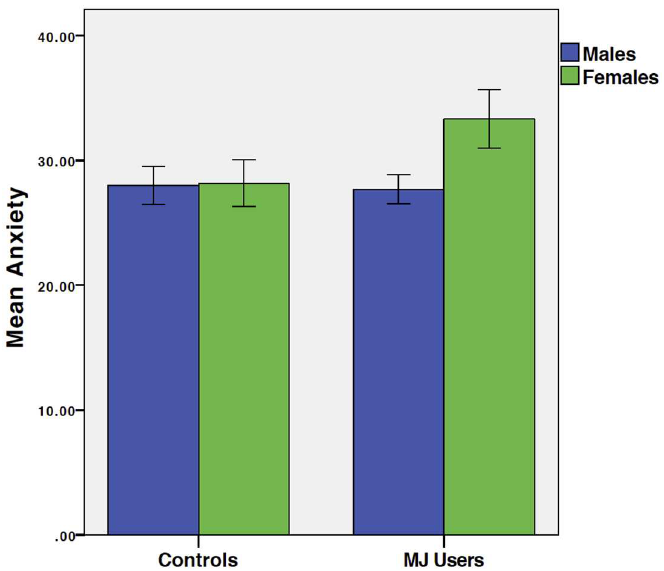
demonstrated increased anxiety symptoms in comparison to males and same-gendered con- trols (see Fig 1). FrSBe Disinhibition was predicted by MJ (cid:3) gender interactions [beta =.22, t = 2.07, p =.04, f 2 =.11], with female users having greater disinhibition (see Fig 2). Covariate Results. Cotinine Results. On the BIS/BAS, increased cotinine level pre- dicted increased drive [beta =.27, t = 2.03, p =.046, f 2 =.55], increased reward responsive- ness [beta =.35, t = 2.70, p =.008, f 2 =.053], and increased BAS System Total [beta =.33, t = 2.50, p =.02, f 2 =.085]. Past year alcohol and ecstasy use did not significantly predict any results.